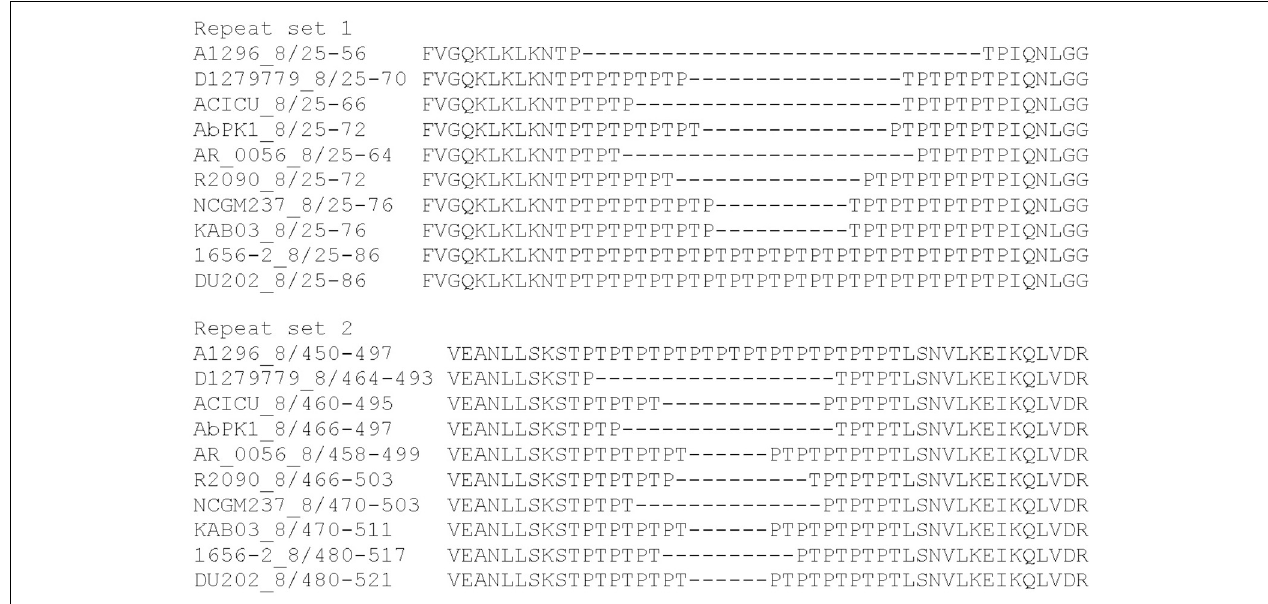
FIGURE 3 | MUSCLE alignment of amino acid repeat sequences present in the A. baumannii group 8 effectors encoded by A. baumannii strains A1296, D1279779, ACICU, AbPK1, AR_0056, R2090, NCGM, KAB03, 1656-2, and DU202.